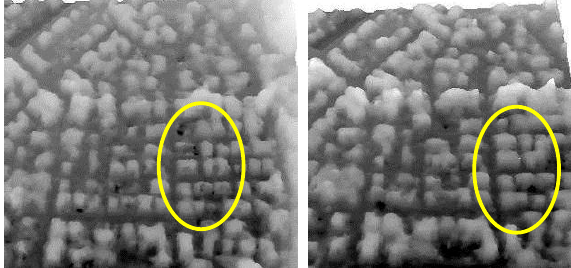
Fig. 7. Zoom in DSMs from stereopair 1-2 (left) and 2-3 (right). The yellow circles highlights differences in the two